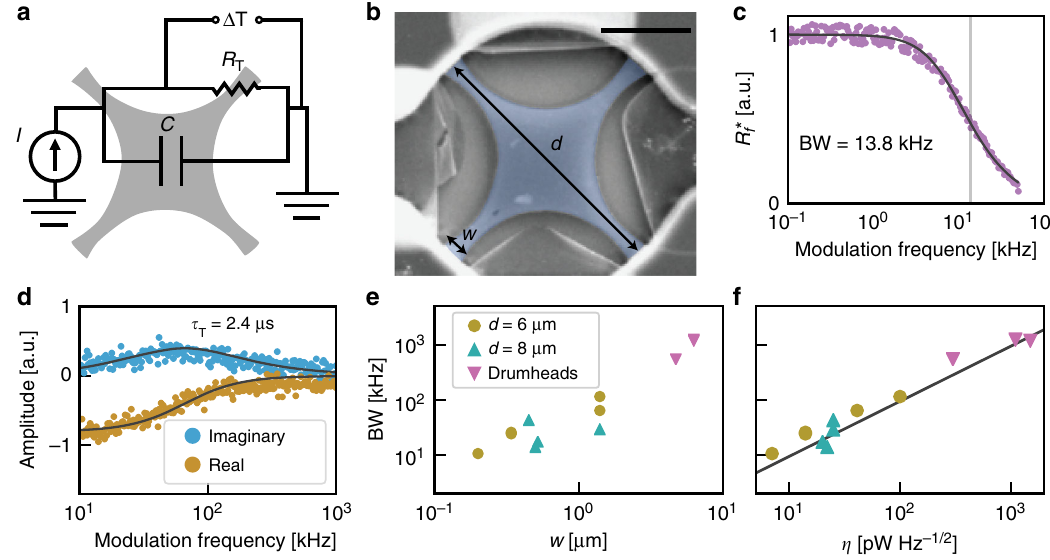
Fig. 3 Modeling and bandwidth measurements of graphene resonators. a Thermal circuit model. b False-colored scanning electron microscope image of a trampoline of tether width w = 200 nm and diameter d = 6 µ m. Black scale bar is 2 µ m. c Normalized frequency-shift responsivity R (cid:6) f as the amplitude of the heating laser is modulated from 100 Hz to 50 kHz. The total resonance shift was found to be constant for low modulation frequency and reached half its maximum value at BW = 13.8 kHz. A thermal circuit model was used to fi t the thermal response time of the trampoline; the fi tted curve using Eq. 2 is shown in black. d Real and imaginary amplitude of thermal expansion induced displacement for a trampoline ( w = 1.2 μ m, d = 6 μ m). The black curve is a fi t ¼ 2 : 4 μ s. e Bandwidth vs. tether width for nine different trampolines to the thermal circuit model. From this fi t, we extract the thermal response time, τ T and three different drumheads. For the drumheads, the tether width is taken to be 1/4 of the drumhead circumference. f Sensitivity vs. bandwidth for nine different trampolines and three different drumheads. The black line is the linear fi t, BW / η ( R -value of 0.97). All bandwidth values in e and f were inferred from the off-resonant thermomechanical method. Symbol legend and vertical axis is shared between e and f . Circles indicate a trampoline with a 6 µ m diameter, turquoise triangles indicate a trampoline with an 8 µ m diameter, and magenta triangles indicate a drumhead resonator of either 6 or 8 µ m diameter. Source data are provided as a Source Data fi ¼ 2 : 4 μ s model fi t (black traces) for a trampoline device with τ T